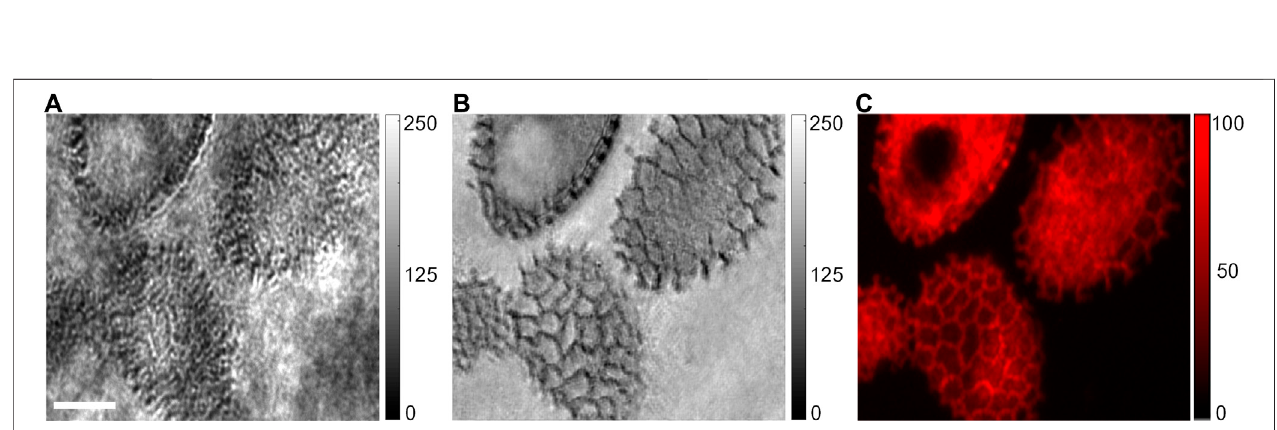
FIGURE4| Dual-modalityimagingoflilyanther.Theimageobtainedusingtheconventionalopticalmicroscopeunderplane-waveillumination (A) andcoherentSIM (B) . (C) Fluorescence image (spectrum band: 600/50 nm) of the same pollens. The scale bar in (A) , 30 μ m.